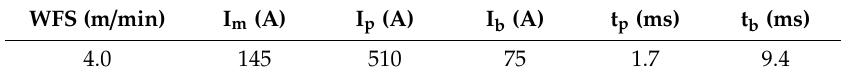
Table 1. Pulsed parametrization for the gas metal arc welding (GMAW) process.